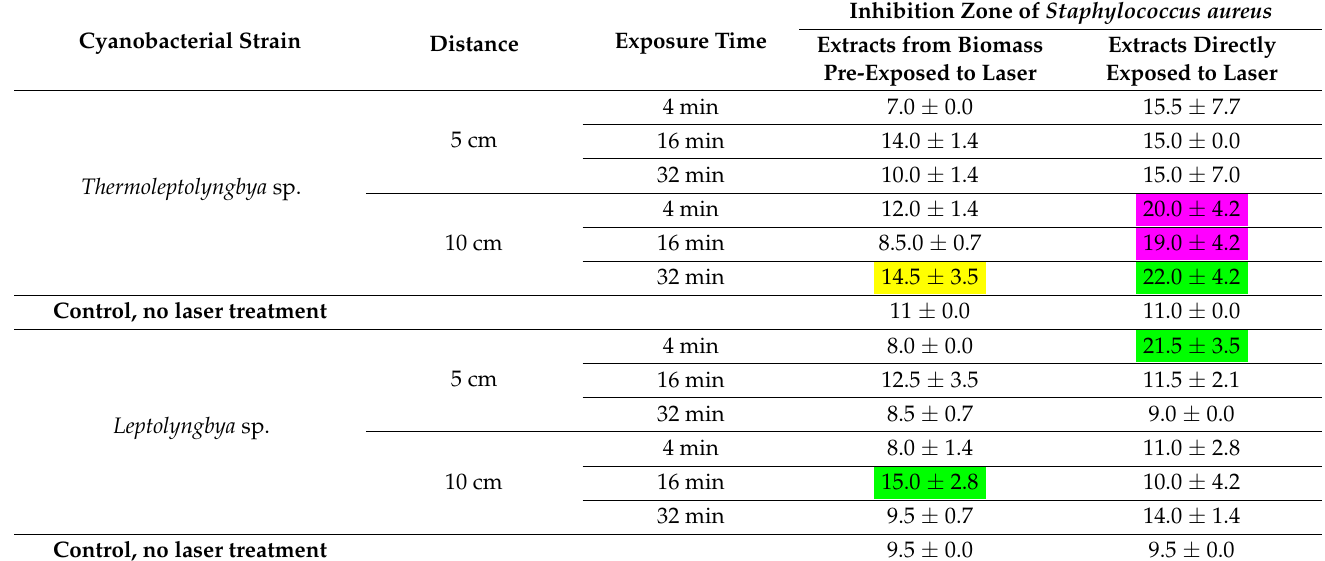
Table 1. Effect of interaction between distance and time intervals as functions of laser dose treatment on the antimicrobial effect of cyanobacterial extracts derived from cyanobacterial biomass pre- exposed to laser and cyanobacterial extracts directly exposed to laser against Staphylococcus aureus. The highest statistically significant result ( p < 0.01) is indicated in green; statistically significant results are indicated in pink ( p < 0.05); highest but statistically nonsignificant results are indicated in yellow.